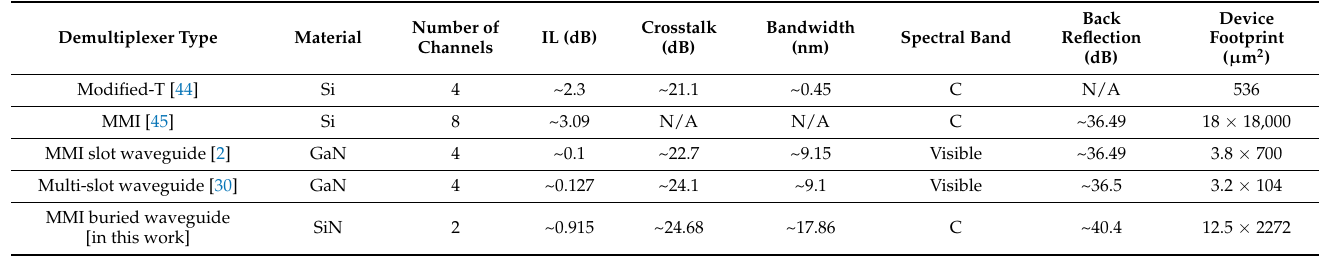
Table 4. A comparison of the main factors between various types of demultiplexer